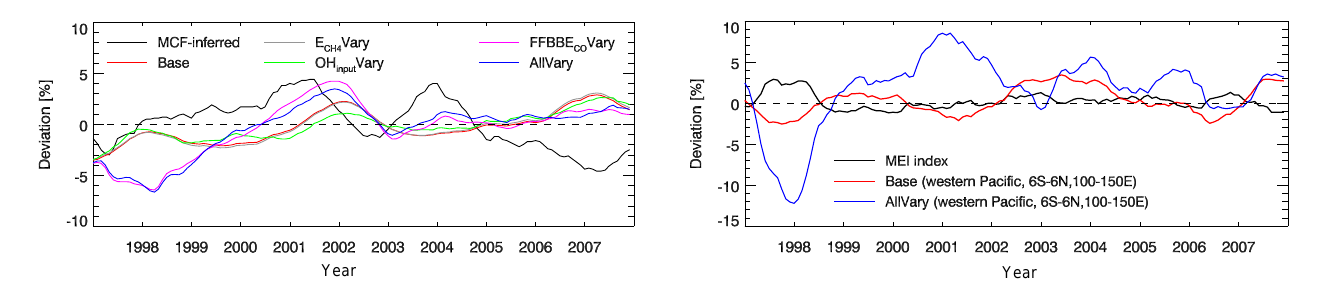
Figure 16. Deviation (%) of global, mass-weighted OH from var- ious scenarios and the Multivariate ENSO Index (MEI). The lines are 12-month running means. Positive values of MEI indicate El Niño conditions and negative values indicate La Niña conditions. The correlation coefficient ( R 2 ) for the Base scenario vs. the MEI index is 0.20, while for the AllVary scenario, it is